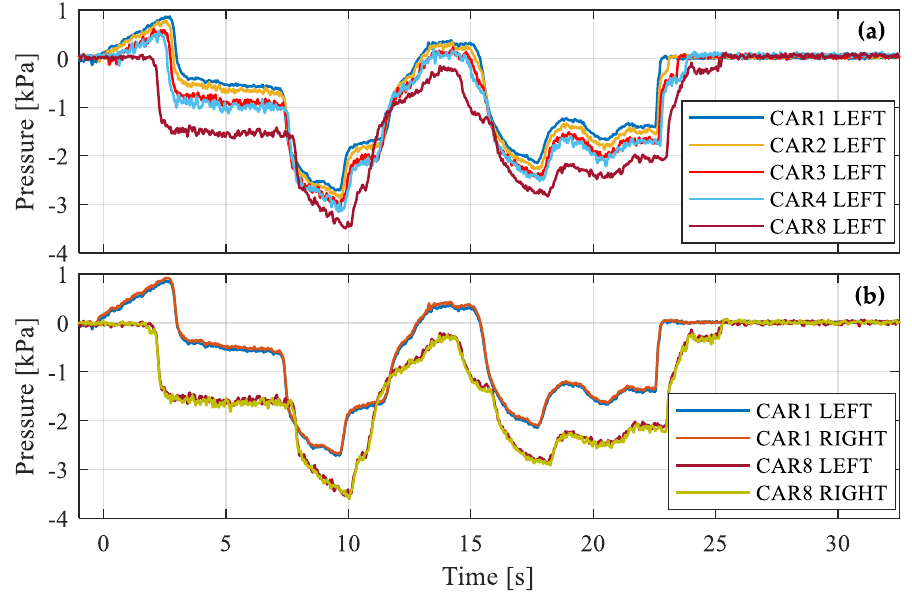
Figure 11. Comparison between the pressure acquired ( a ) in different positions and ( b ) on different sides of the sealed train.